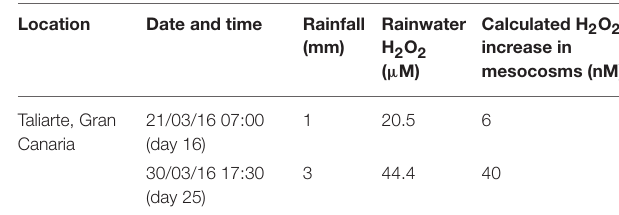
TABLE 1 | Contribution of rainwater events to H 2 O 2 concentrations in the